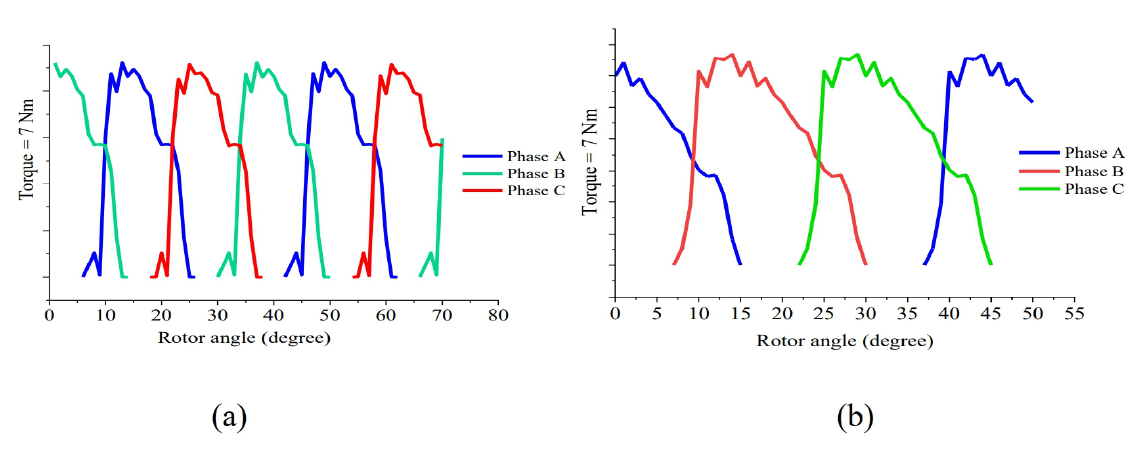
Fig. 5. Flux linkage 8/6 and 10/6 (a) misaligned, (b) unaligned, (c) aligned, (d) aligned, (e) misaligned, (f) unaligned.